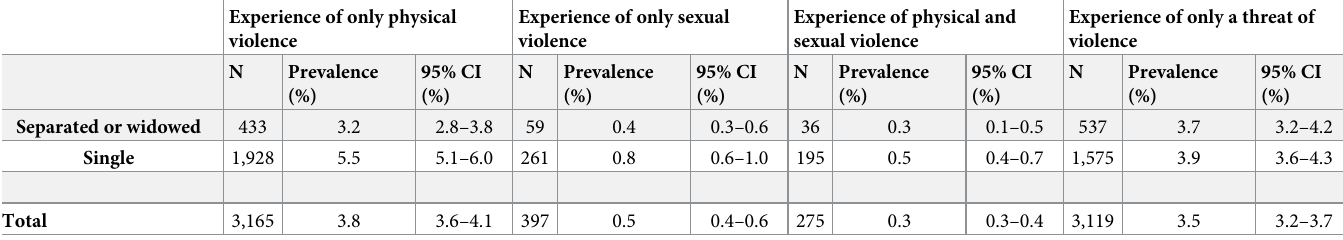
violence. Regression models on depression and violence Logistic regression models were used to assess the associations between depression and vio- lence whilst adjusting for socioeconomic factors (Table 4). In separate models for each type of depression diagnosis, an experience of any type of violence was associated with significantly higher odds of depression. Individuals who experienced physical violence or a threat of vio- lence were 2.5 times more likely to have clinician-diagnosed depression (aOR = 2.54, 95% CI 2.11–3.06 and aOR = 2.50, 95% CI 2.13–2.93 respectively), and 3.5 times more likely to have